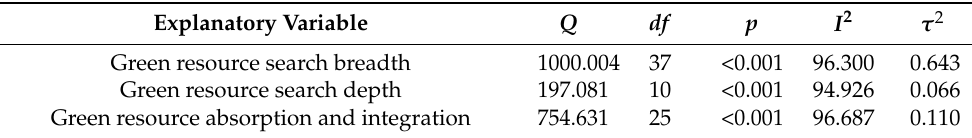
Table 2. Test Results of the Heterogeneity of Effect Quantity.